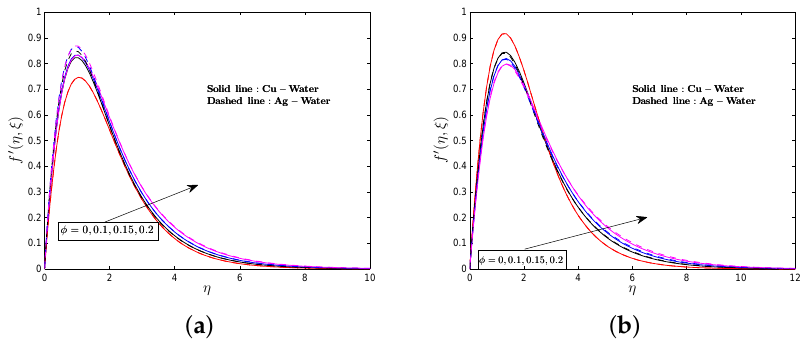
Figure 5. Velocity profiles for various values φ . ( a ) vertical plate; ( b ) horizontal plate.